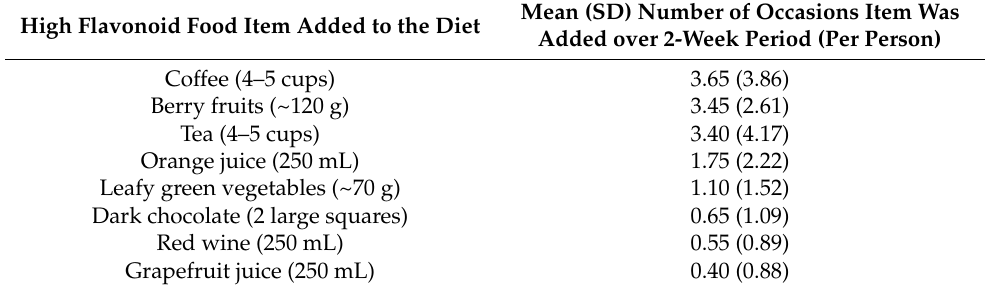
Table 2. Breakdown of the number of high flavonoid foods added to the diet per person across the 2-week intervention in the flavonoid diet group ( n = 20). Units represent the average (SEM) number of occasions an item was consumed per person across 2